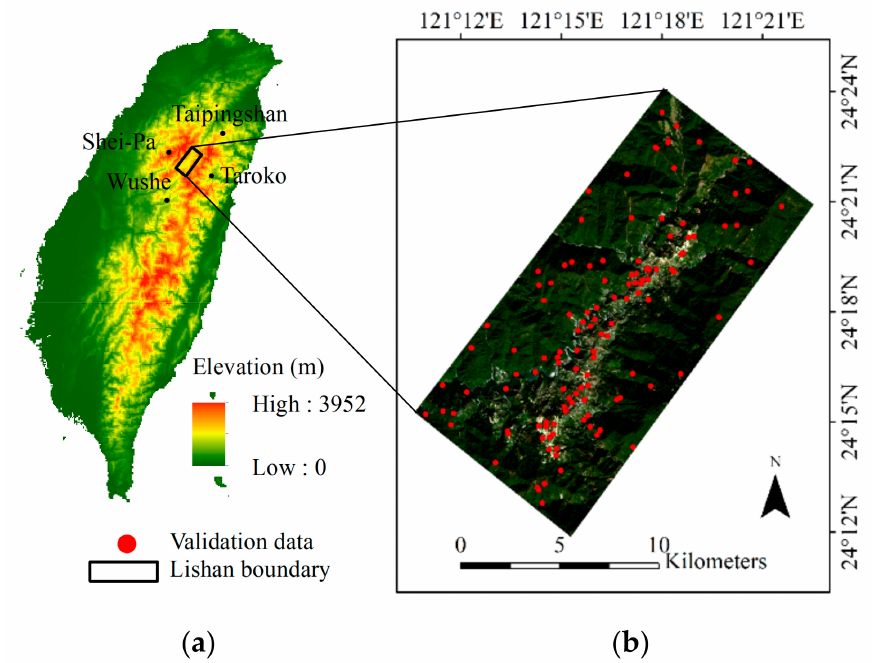
Figure 1. The digital elevation model (DEM) of Taiwan overlaid with the boundary of the study site ( a ); and geolocations of the validation dataset overlaid with a Sentinel-2 natural-color image ( b